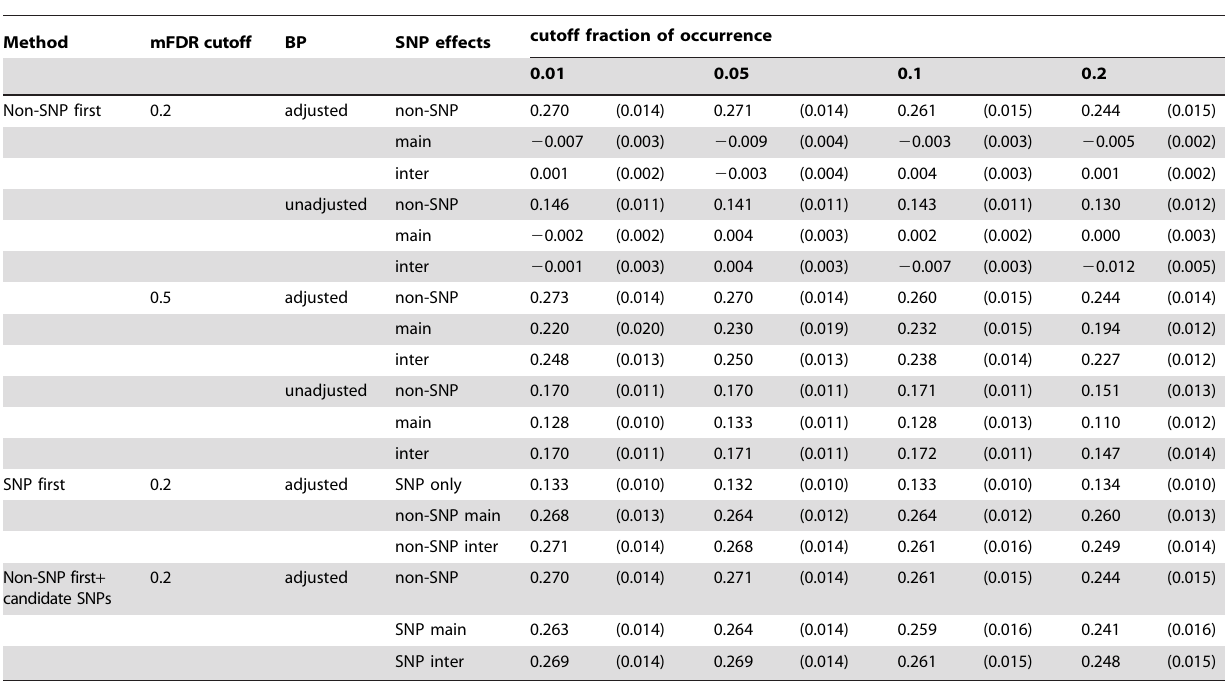
Table 2. Coefficient of determination ( R 2 ) estimated using 10-fold cross validation of our adaptive prediction algorithm.